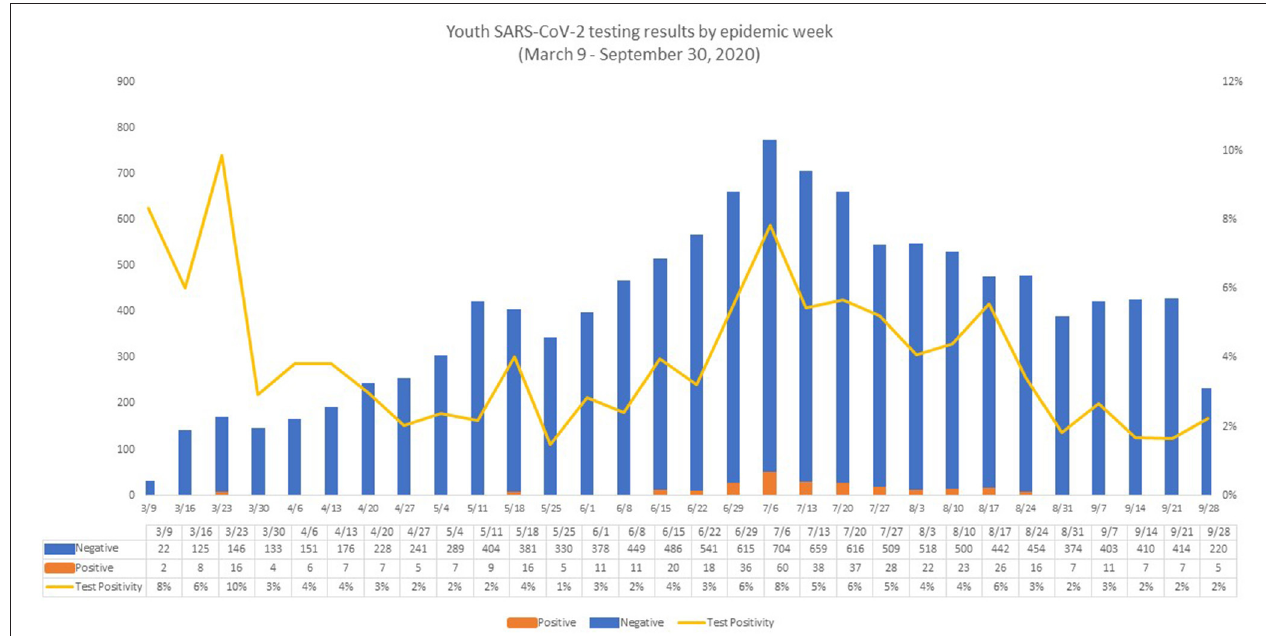
FIGURE 5 | Youth SARS-CoV-2 testing results by epidemic week. The figure reflects the evolution of the pandemic in Los Angeles County, with very few positive tests in the first week (two positive SARS-CoV-2 PCR tests) and in the last week of the study period (five positive SARS-CoV-2 PCRs). The number of positive SARS-CoV-2 PCR tests peaked in week 18 (July 6, 2020 to July 12, 2020), corresponding roughly with the summer peak of COVID-19 in Los Angeles County ( 23, 24). During week 18, the number of both positive and negative SARS-CoV-2 PCR tests reached the highest number during our observation period, with 60 positive SARS-CoV-2 PCRs and 704 negative SARS-CoV-2 PCRs, resulting in a positivity rate of 7.8%. Week 1 also showed a high positivity rate (6.7%), but a low number of tests were performed ( n = 30) with the lowest number of positive tests ( n = 2) observed that week. After the Week 18 peak, the number of positive tests remained elevated (22–37 positive tests/week) until week 25 (August 24, 2020 to August 30, 2020). At that point, the number of positive results began to